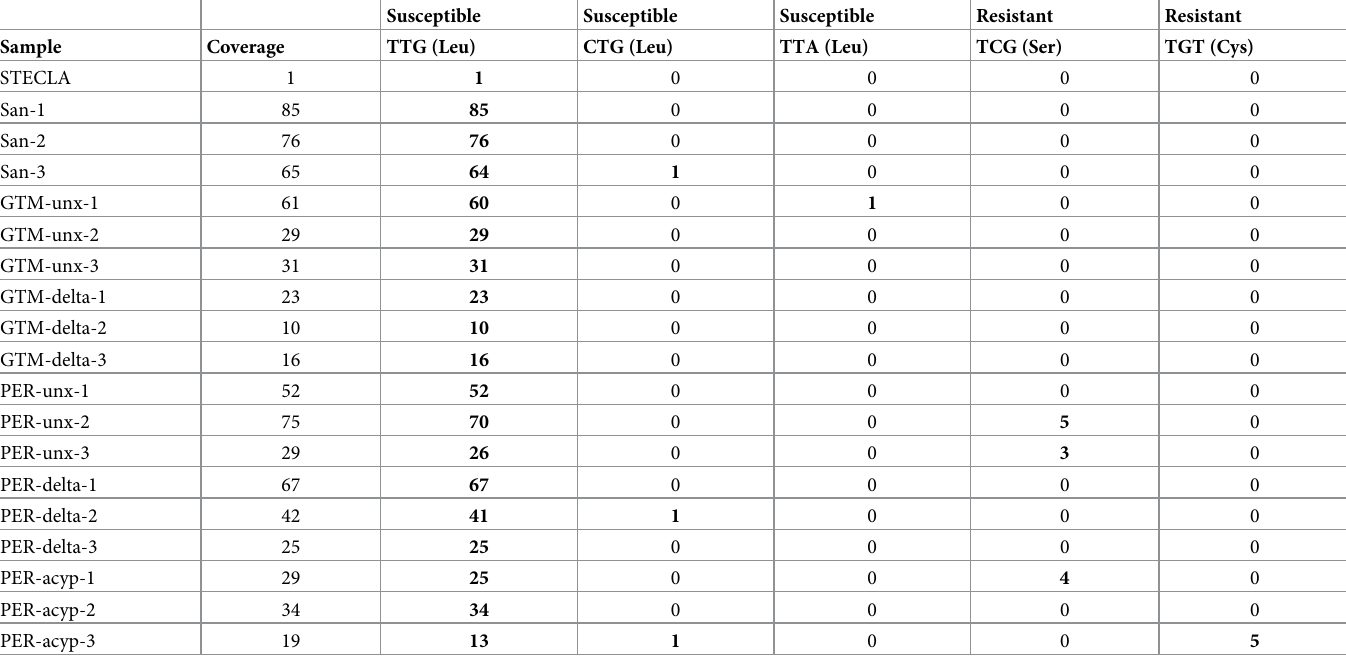
Table 3. Codons present in RNA-seq reads at the kdr position ‘1014’ of the voltage gated sodium channel gene.